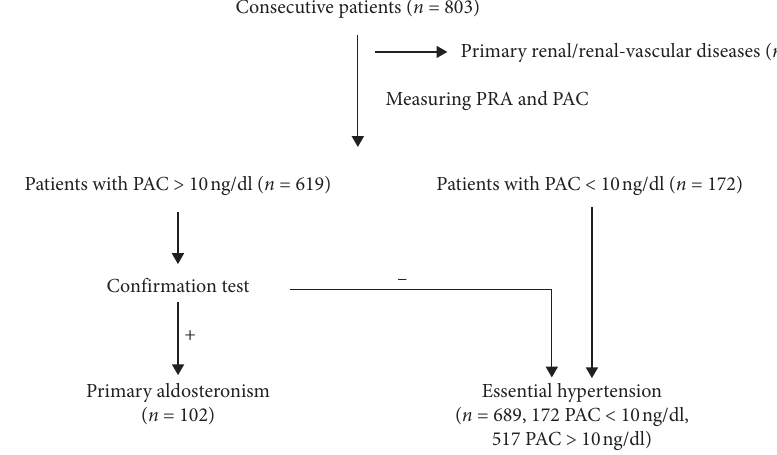
Figure 1: Flow diagram of the